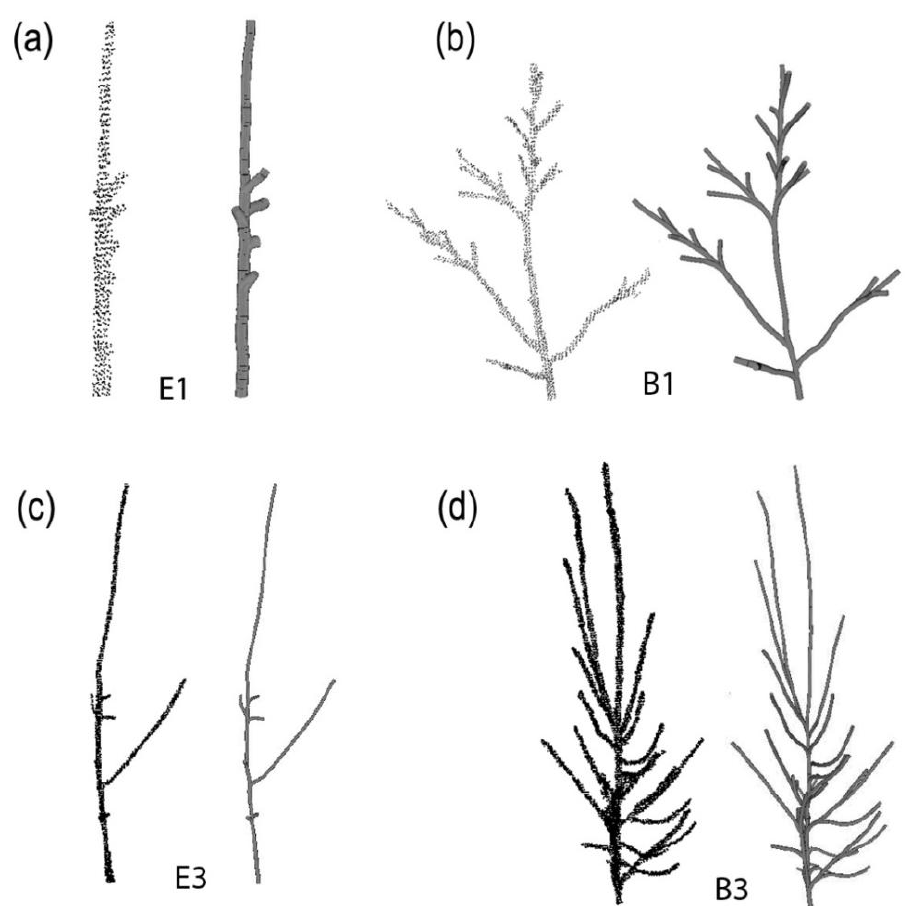
Figure 8. Reconstruction of 3-year-old saplings grown under contrasting light regimes. ( a ) E1: sugar maple under low light reconstructed using k = 10, r = 0.03, d = 100 and w = 5; ( b ) E3: sugar maple under high light reconstructed using k = 4, r = 0.03, d = 90 and w = 5; ( c ) B1: yellow birch under low light reconstructed using k = 5, r = 0.02, d = 30 and w = 3; ( d ) B3: yellow birch under high light reconstructed using k = 7, r = 0.01, d = 100 and w = 5.